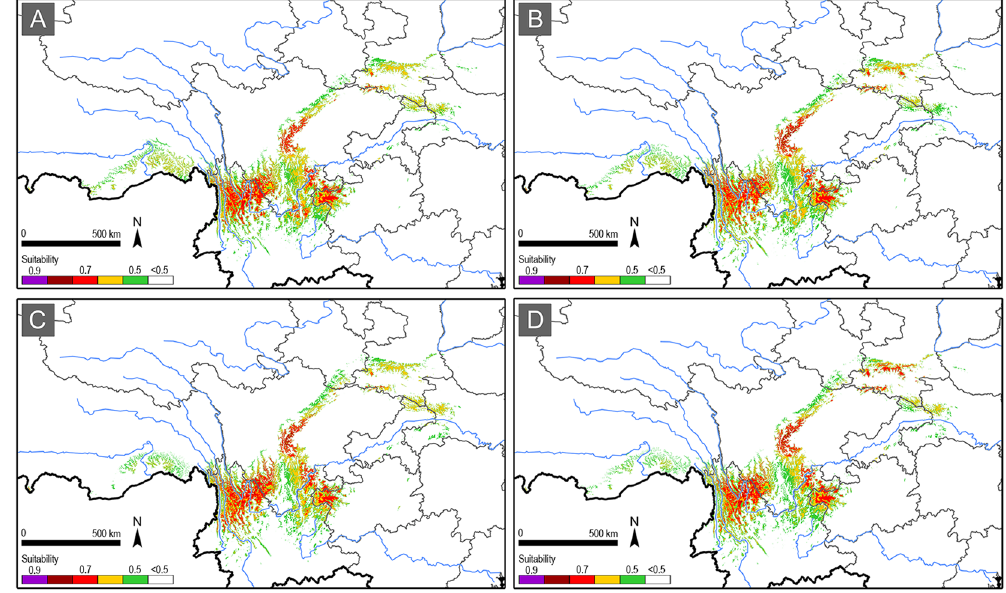
Figure 4. The suitable areas for B. thaidina in China in the 2050 s under the RCP2.6 ( A ), RCP4.5 ( B ), RCP6.0 ( C ), and RCP8.5 ( D ) scenarios.